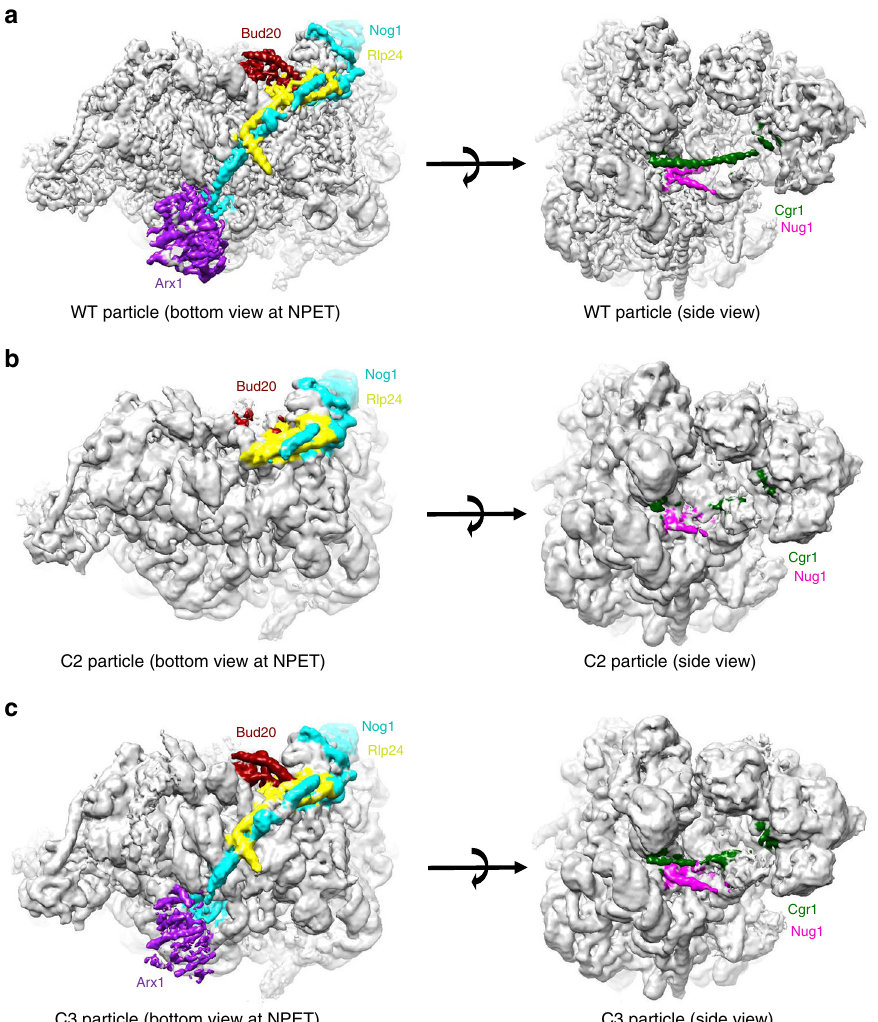
Fig. 8 NPET maturation and nuclear export are affected in the rpf2 Δ 255-344 mutant. a Subunit interface view (left) and side view (right) of the density map of wild-type particles. Densities for Nog1, Arx1, Bud20, Rlp24, Nug1, and Cgr1 were colored using Color Zone in Chimera. b Same as in a for the C2 class of rpf2 Δ 255-344 mutant particles. Densities for the CTD of Nog1, all of Arx1, the CTD of Rlp24, and portions of Bud20, Nug1, and Cgr1 are absent in the C2 class. c Same as in a for the C3 class of rpf2 Δ 255-344 mutant particles. Densities for Nog1, Arx1, Rlp24, Bud20, Nug1, and Cgr1 are present in the C3 class of rpf2 Δ 255-344 mutant